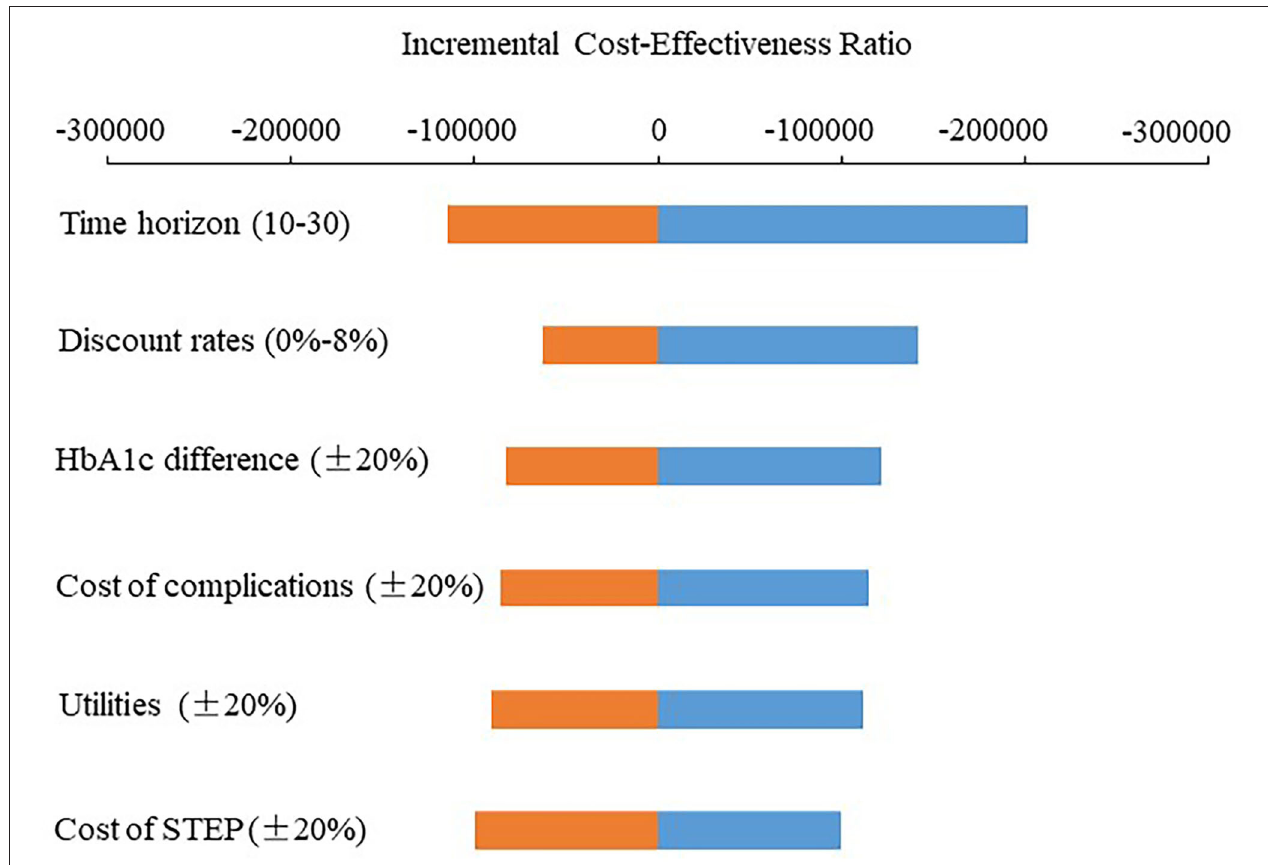
FIGURE 2 | Tornado diagram of the SSEP compared with routine education.